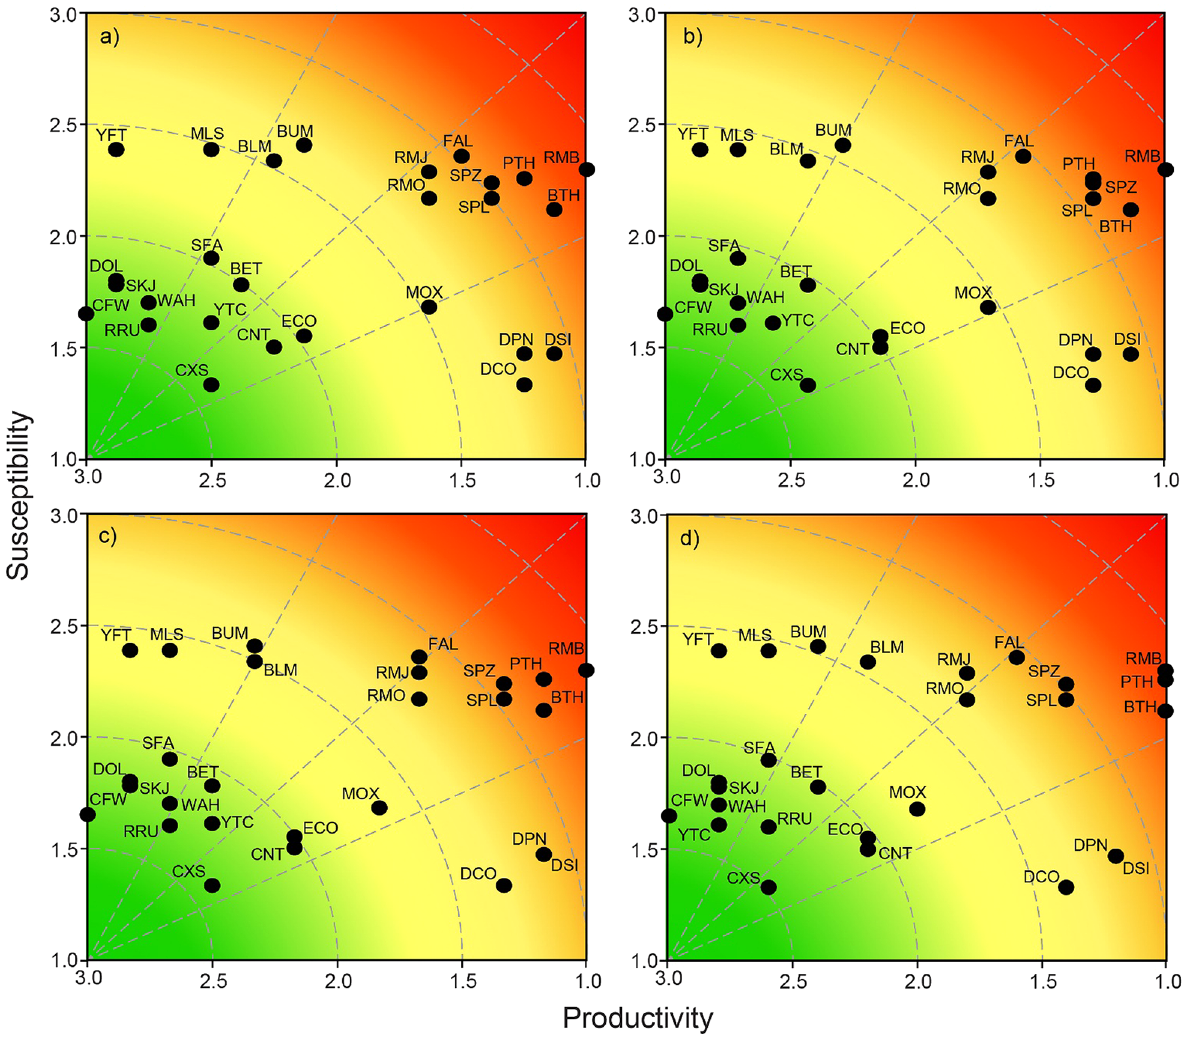
Fig. 5. Scatterplots of PSA results involving productivity attribute reduction: (a) v 1 = no mean trophic level (TL); (b) v 2 = attributes in v 1 and without the intrinsic rate of population growth ( r ); (c) v 3 = attributes in v 2 and without maximum age ( A max ); (d) v 4 = attributes in v 3 and without natural mortality ( M ). Species codes are de fi ned in Table 3. (For interpretation of the references to colour in this fi gure legend, the reader is referred to the web version of this